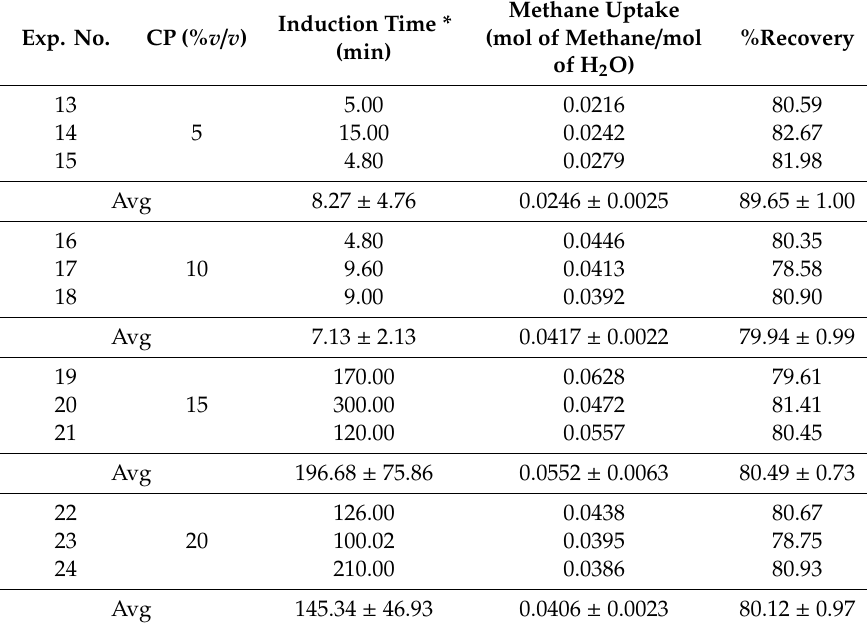
Table 2. Methane hydrate formation in the presence of di ff erent cyclopentane (CP) concentrations at 2.5 ◦ C and 8 MPa.